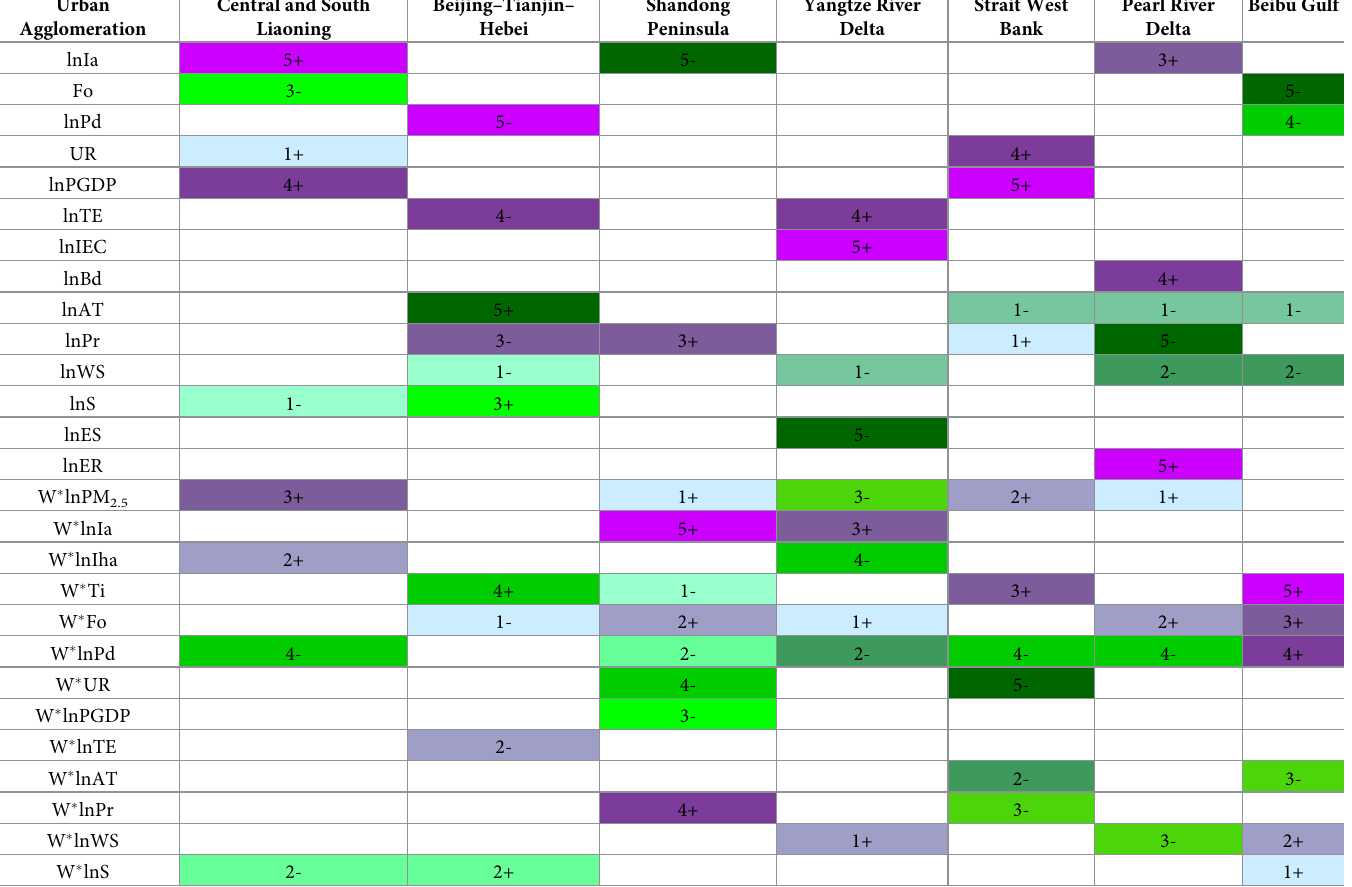
Table 5. Rankings of the contributions of different factors to PM 2.5 concentration in China’s coastal urban agglomerations. Urban